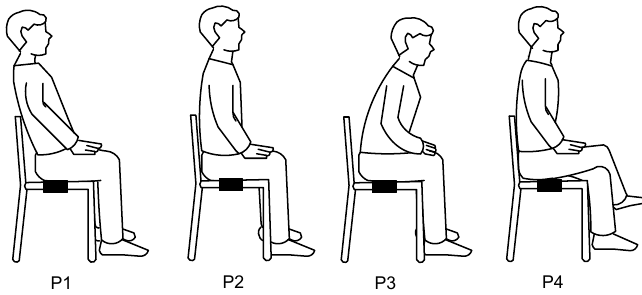
Figure 5. Different sitting postures of the subject to test the proposed measurement system.